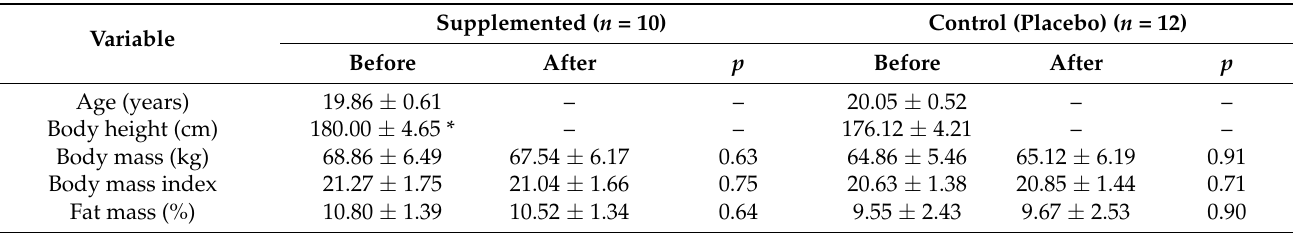
Table 2. The characteristics of participants before and after supplementation with a lyophilizate of black chokeberry extract (mean ±